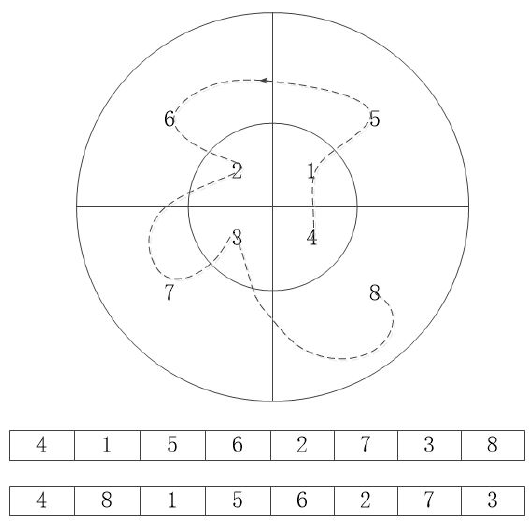
Figure 3. Illustration of the threading-needle method.